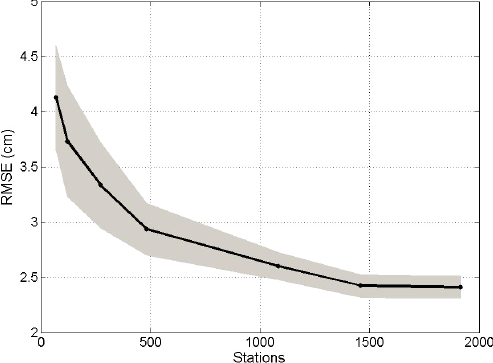
Figure 5. Root mean square errors (cm) associated with the altime- try maps recovered throughout 2014 from the different regular sub- sampled fields mentioned in the text. The black line represents the yearly mean value and the grey patch stands for the annual variabil-